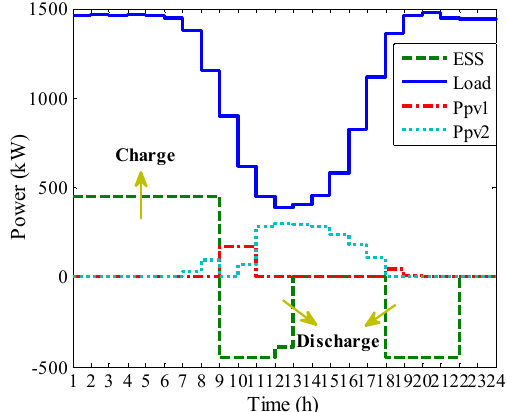
Figure 10. The operated curves when the power and the capacity of Li-ion battery are 450 kW and 3600 kWh, respectively.